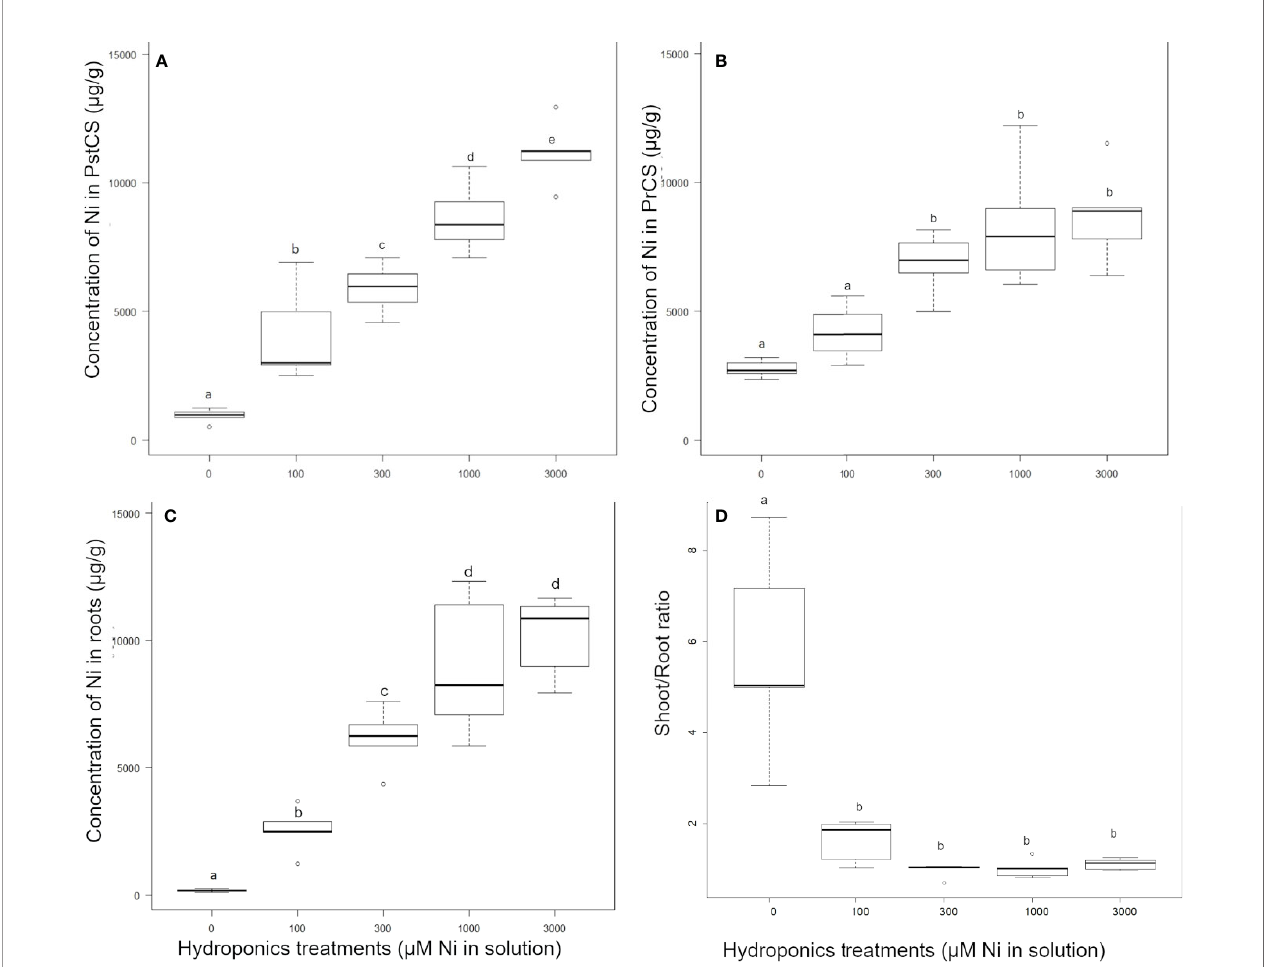
FIGURE 2 | Effect of nickel concentrations in the nutrient solution on the nickel concentration in Pycnandra acuminata , after 180 days of growth in hydroponics (n=5). (A) PrCS, (B) PstCS, (C) root and (D) shoot to root ratio. Letters indicate signi fi cant difference at 5% level (Waller-Duncan k-ratio